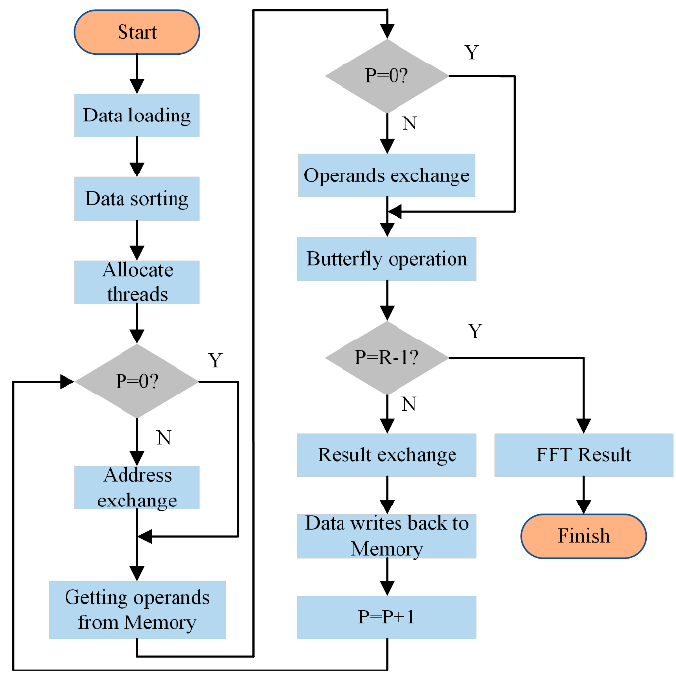
Figure 12. The flow chart of fast Fourier transform (FFT) algorithm on GPU.